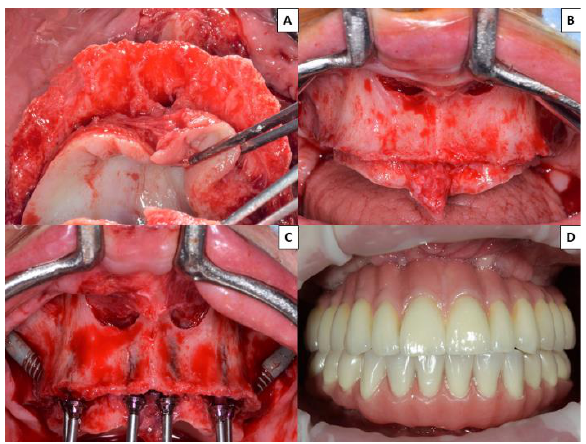
Figure 2. Group 1 patients with atrophic maxilla rehabilitated with two zygomatic implants and four conventional implants in the premaxilla. ( A ) Occlusal image of severe atrophied maxilla. ( B ) Front view of atrophic maxilla. ( C ) Placement of two zygomatic implants and four conventional implants in the anterior region. ( D ) Fabrication of definitive fixed prosthesis 6 months after surgery.